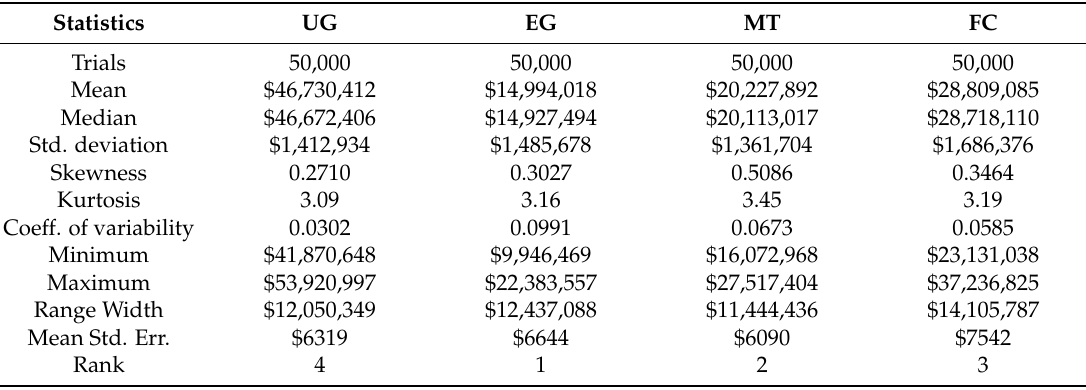
Table 5. Monte Carlo simulation results for Town B.